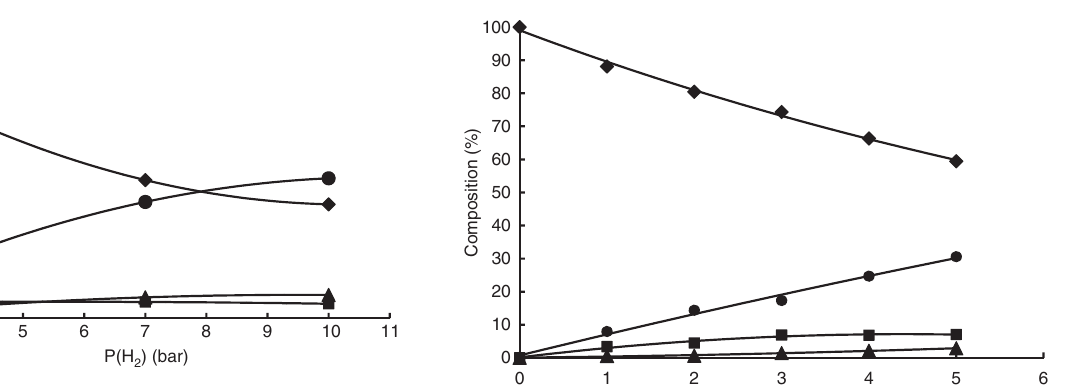
Figure 1 Effect of pressure on the hydrogenation of cinnamalde- hyde with [RuH(OAc)( m tppms) ] catalyst.  cinnamaldehyde, ■ 3 Figure 3 Time-course of the hydrogenation of cinnamaldehyde 3-phenyl-2-propanal,  3-phenyl-2-propan-1-ol, ● 3-phenyl-2-pro- with [RuH(OAc)( m tppms) ] catalyst.  cinnamaldehyde, ■ 3-phenyl- pen-1-ol. Conditions: 0.01 mmol catalyst, 0.8 mmol cinnamalde- 3 2-propanal,  3-phenyl-2-propan-1-ol, ● 3-phenyl-2-propen-1-ol. hyde, 3 ml water, 80 ° C, 4 h. Conditions: 0.01 mmol catalyst, 0.8 mmol cinnamaldehyde, 3 ml phosphate buffer (pH 7.0), 80 ° C, P(H ) = 7 2 the rate (Figure 2) and product distribution: the yield of 3 increased to 14.8% at pH 5.5. The yield of 2 varied from 3.3% (pH 3.6) to 6.2 % (pH 5.5), while that of 4 remained below 2%, so that at pH 5.5 cinnamyl alcohol was domi- nant (64%) among all hydrogenation products.